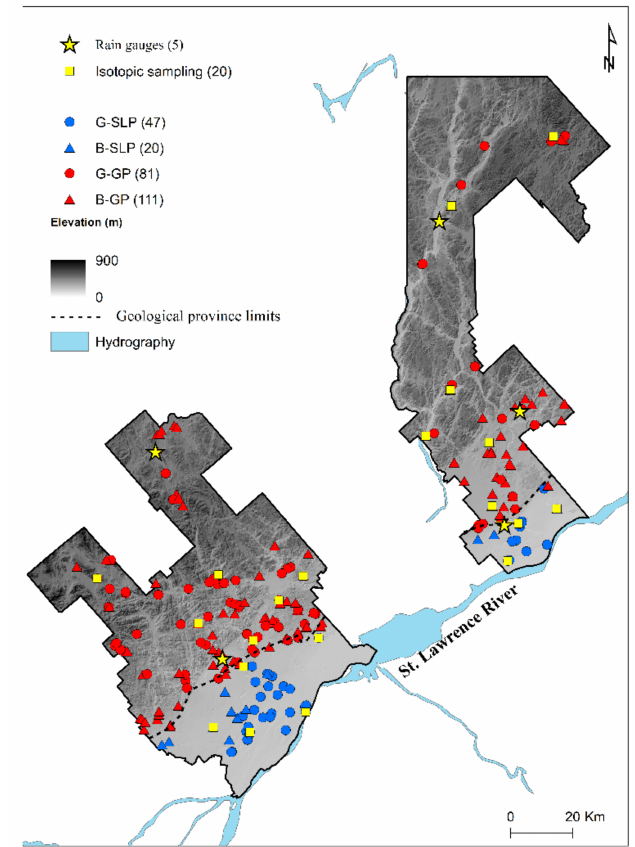
Figure 2. Location of the sampling sites classified according to their respective aquifer type and geological province. The St. Lawrence Platform has 67 sampling sites distributed in granular (G-SLP) and bedrock aquifers (B-SLP), whereas Grenville Province has 192 sampling sites distributed in granular (G-GP) and bedrock aquifers (B-GP). The five rainwater gauges are represented by yellow stars. The 20 sampling sites for isotopic analyses are represented by yellow